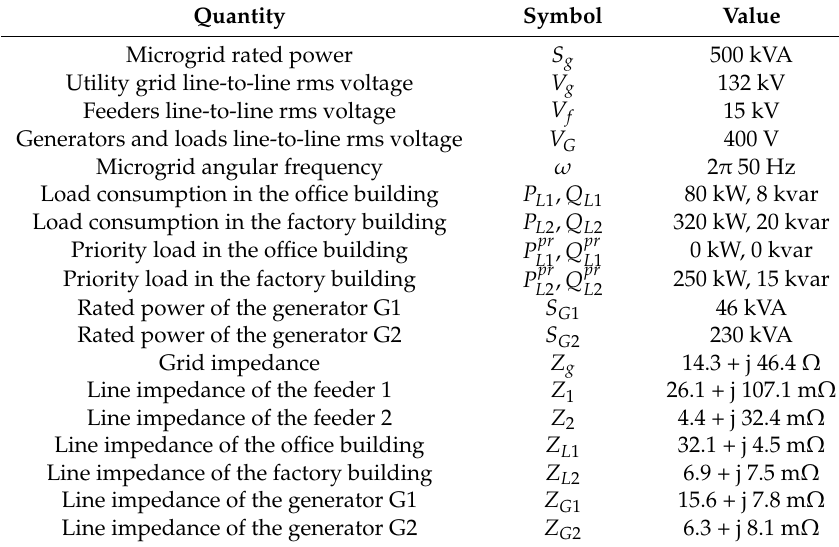
Table 1. Nominal values of the microgrid components.